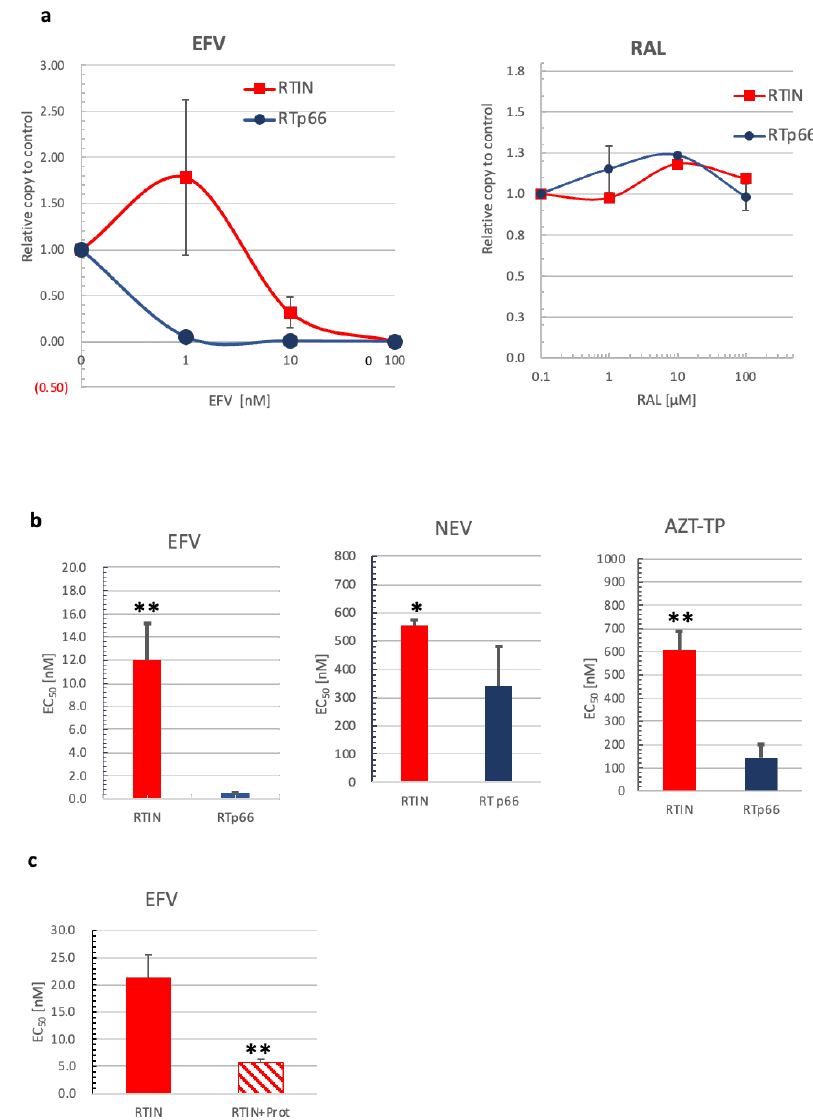
Figure 5. Effect of IN fusion on sensitivity to RT inhibitors. ( a ) An in vitro reverse transcription assay was performed in the presence of different concentrations of efavirenz (EFV) or raltegravir (RAL). Levels of R/u5 products were measured and are shown as values relative to the level with solvent (DMSO) only as 1.0. ( b ) The effective concentration 50 (EC 50 ) of EFV, nevirapine (NEV), or 3‘ -Azido- 2′,3‘ -dideoxythymidine- 5′ -triphosphate (AZT-TP) for RTIN or RTp66 was determined by calculating the drug concentration to inhibit 50% of RDDP activity relative to control. Student’s t analysis showed significant differences between rRTIN and RTp66 (** p > 0.01, * p > 0.05, n = 3). ( c ) The effect of cleavage by HIV-1 protease on the EFV sensitivity of RTIN was examined as described in a. The EC 50 of EFV for rRTIN with or without pretreatment with HIV-1 protease is shown. Student’s t analysis showed that rRTIN had significant effect on EC 50 by pretreatment with HIV-1 protease (** p > 0.01, n = 3).